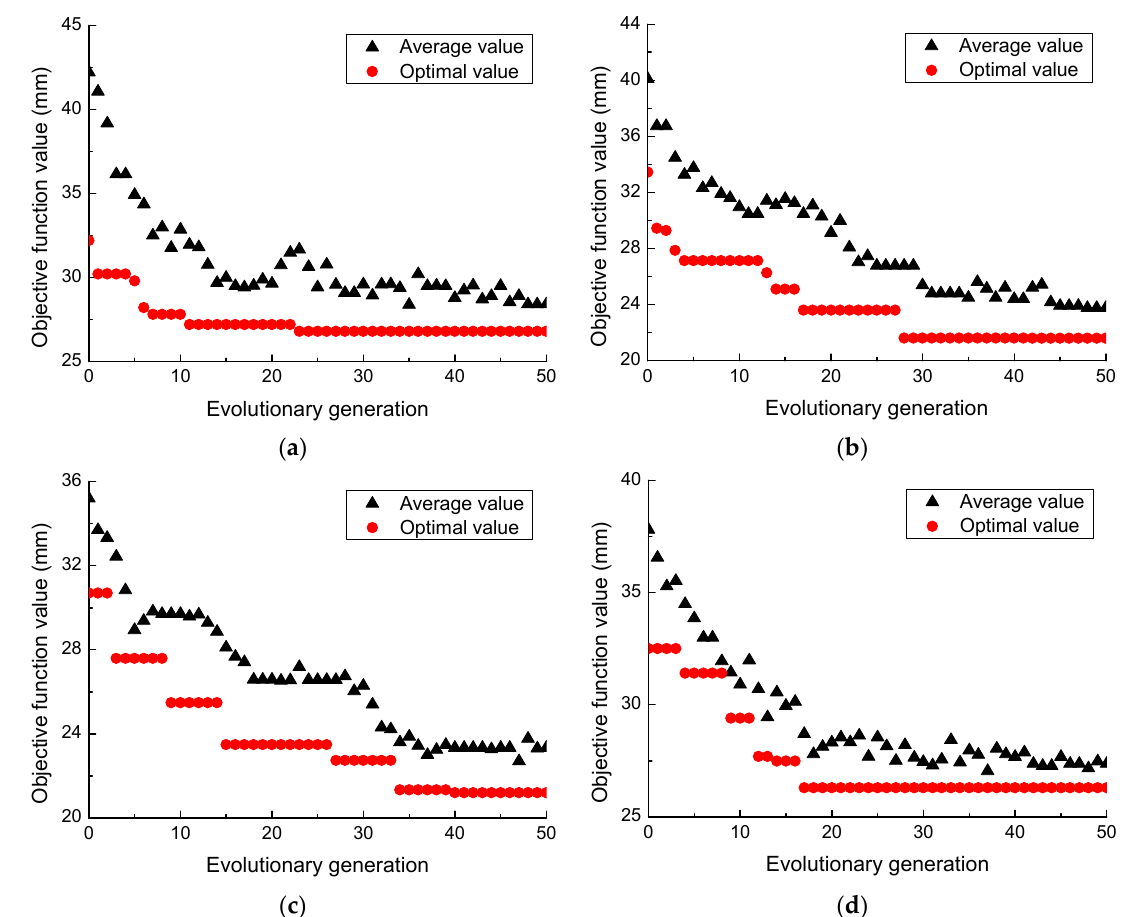
Figure 12. Objective function values with the change of evolutionary generations under different amounts of SMA wire, ( a ) 4 SMA wires, ( b ) 8 SMA wires, ( c ) 12 SMA wires, ( d ) 20 SMA wires.